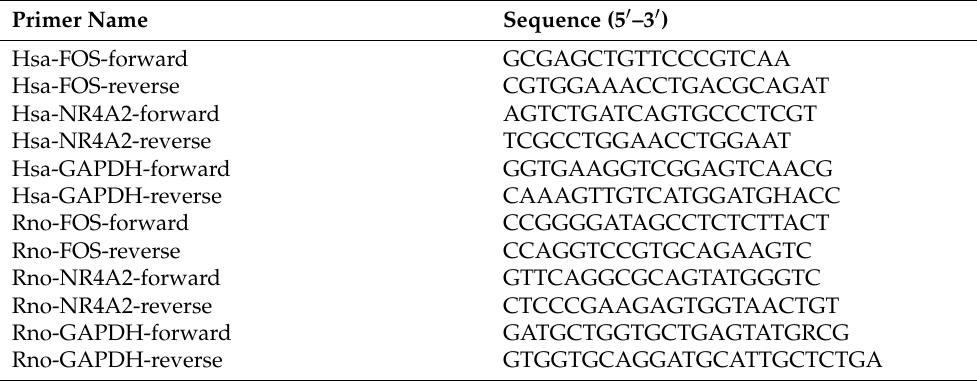
Table 2. Primers used for RT-PCR.